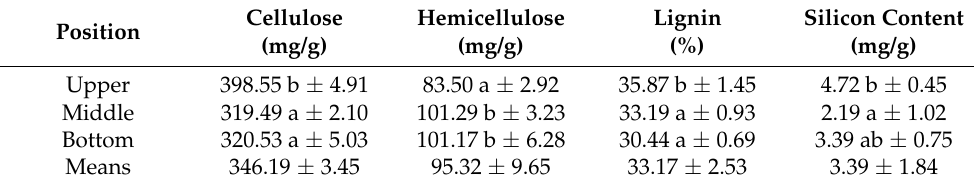
Table 2. Chemical composition of T. oliveri .